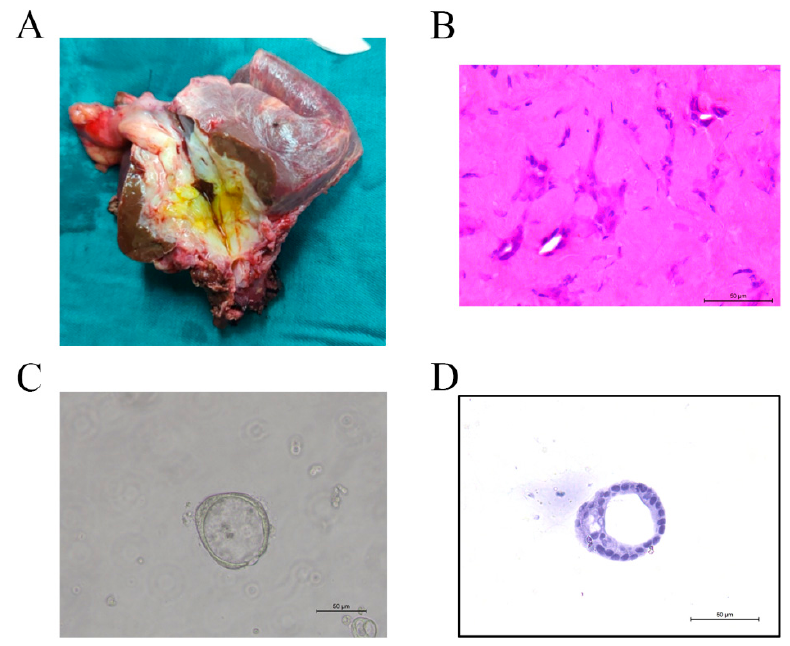
Figure 3. Histopathological characterization of cancer organoid. ( A ) Gross specimen and ( B ) H&E staining of intrahepatic cholangiocarcinoma (IHCC) tissue, and ( C ) bright-field image and ( D ) H&E staining of the cancer organoid. Scale bar, 50 µM.